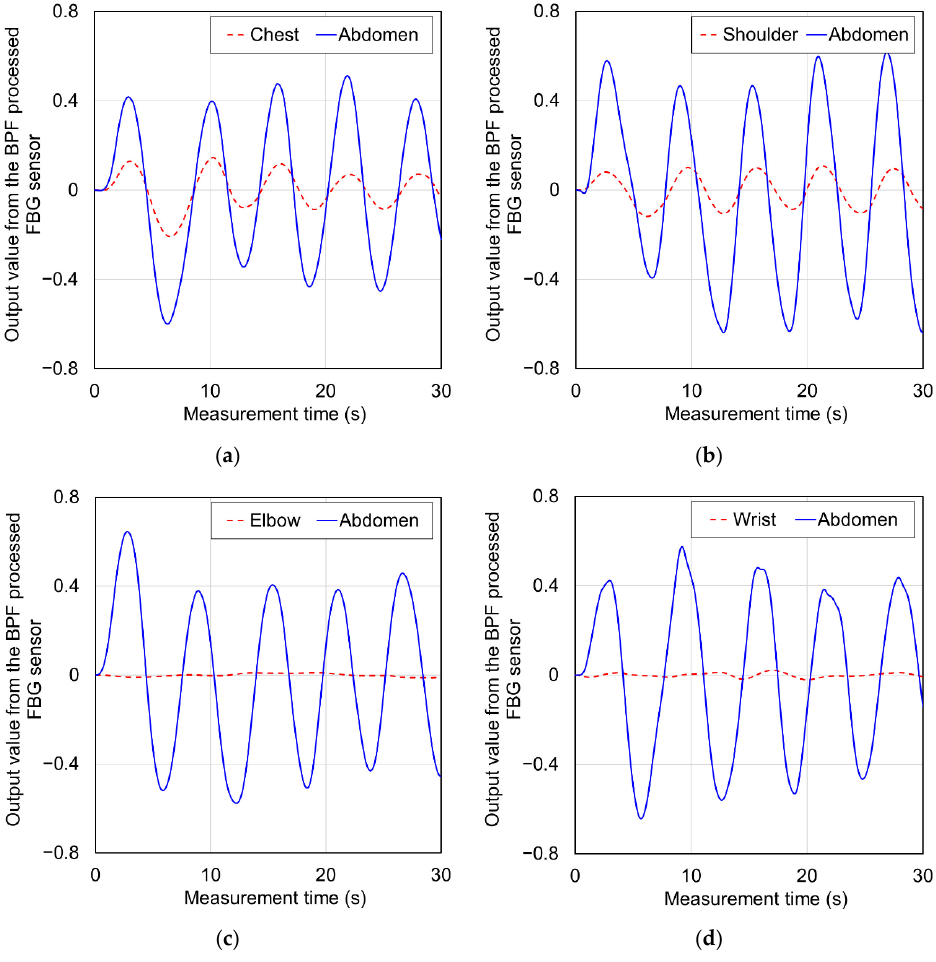
Figure 9. Measured signal waveforms on the chest, shoulder, elbow, wrist, and simultaneously measured on the abdomen. ( a ) Chest, ( b ) Shoulder, ( c ) Elbow, and ( d ) Wrist.